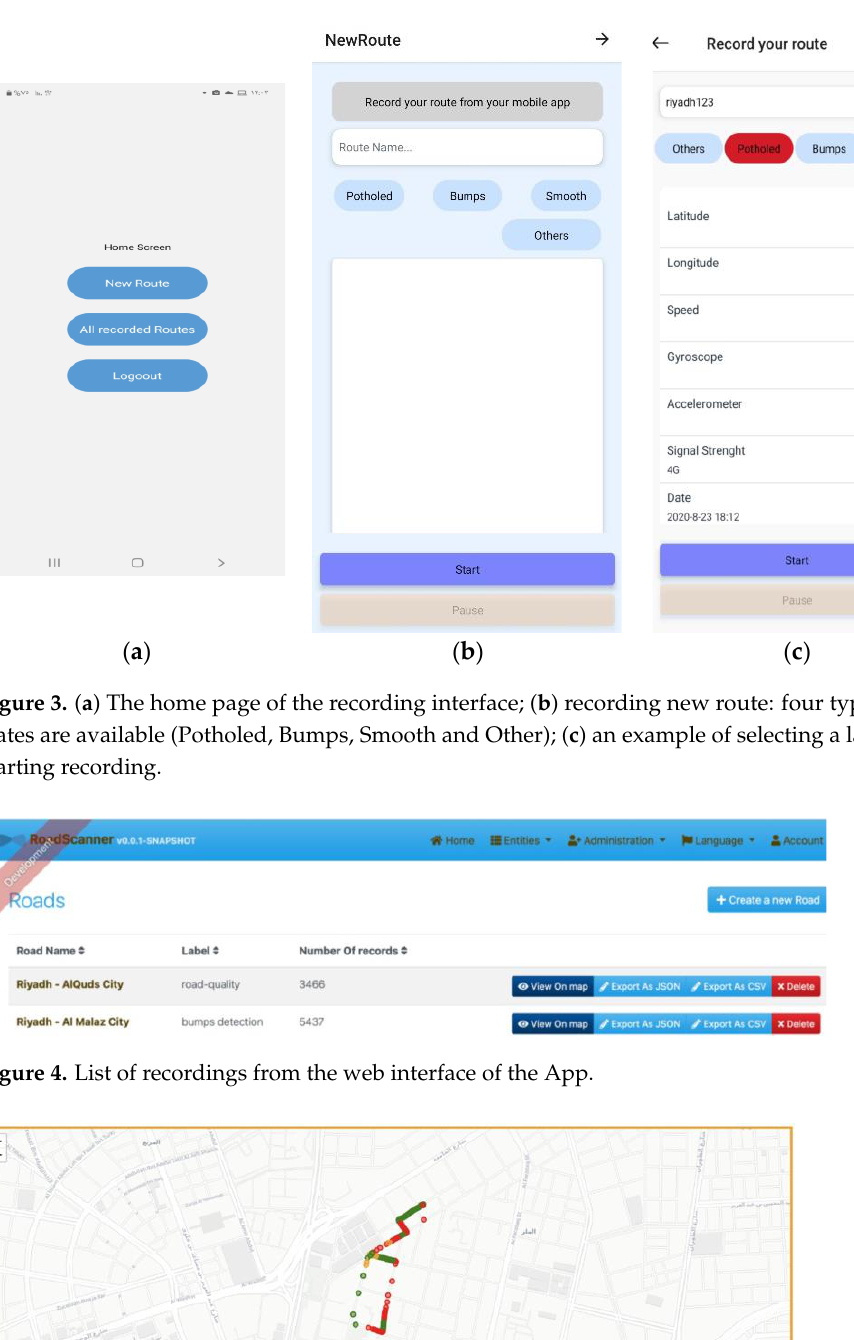
Figure 5. Map visualization with playback features. The circles represent samples of recording while their colors represent their corresponding labels (“Potholed”, “Bumps”, “Smooth”, and “Other”).